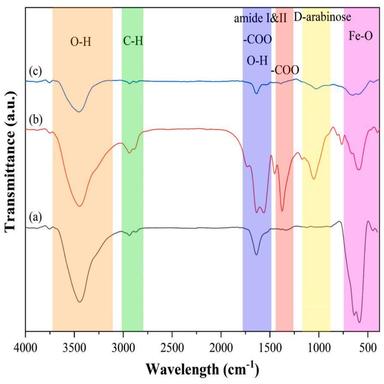
FT-IR spectra of (a): Fe3O4, (b): Fe3O4/QSM, and (c): Fe3O4/QSM/Ag.